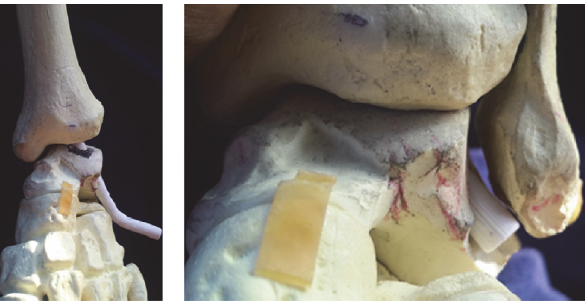
Figure 8: Varus angulation for insertion and normal tibiotalar relationship after full seating.